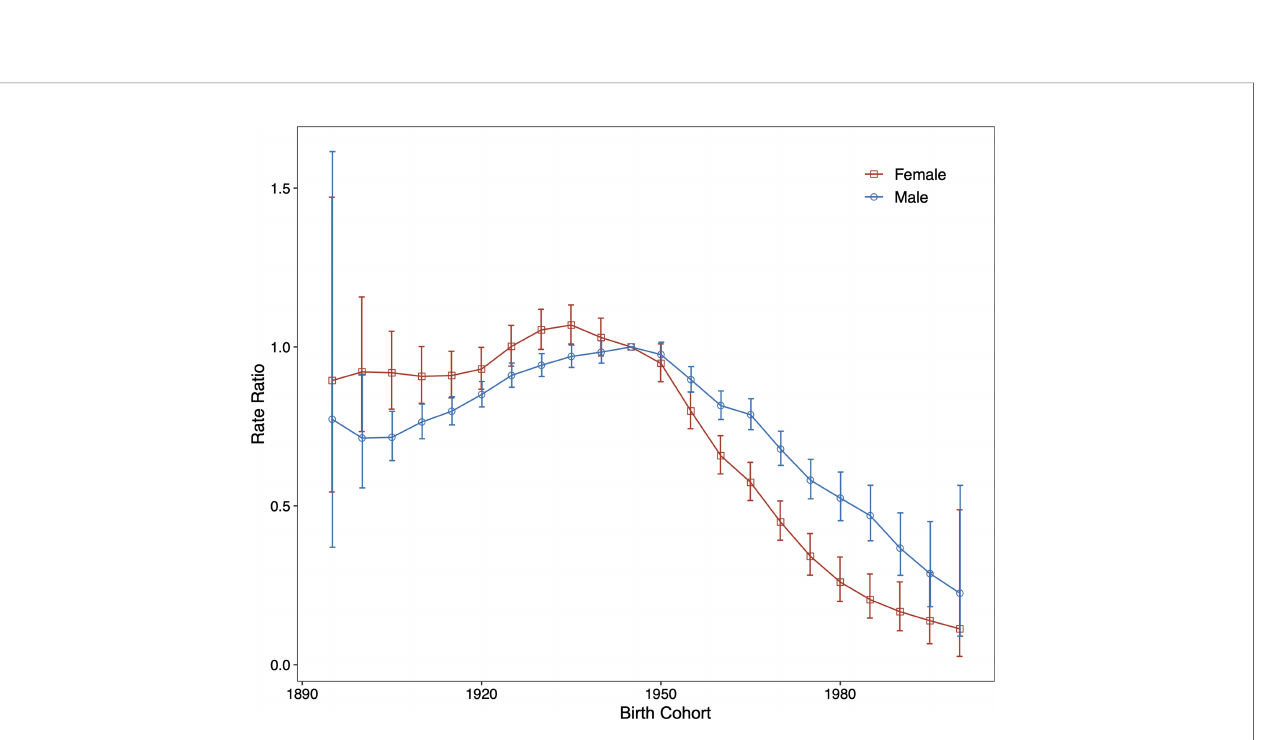
FIGURE 5 | Relative risk of each cohort compared with the reference cohort (cohort 1945 – 1949) adjusted for age and nonlinear period effects and the corresponding 95% con fi dence interval.